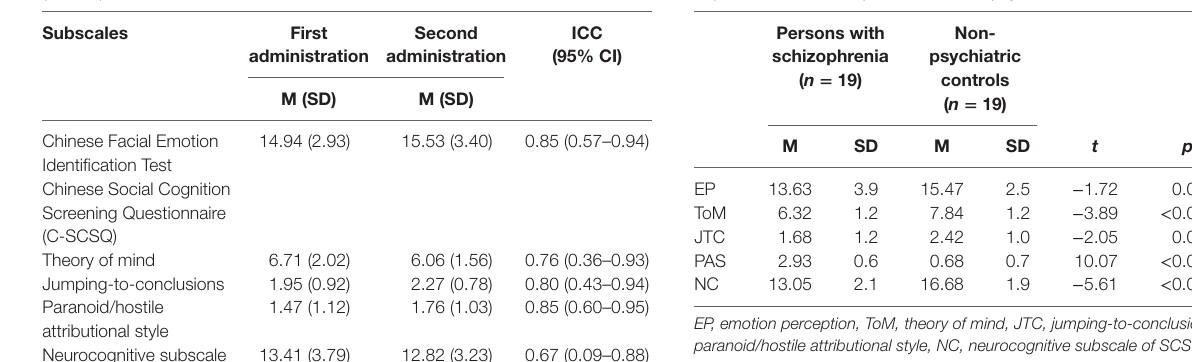
TaBle 4 | Comparison of social cognitive performance between matched pairs of persons with schizophrenia and non-psychiatric controls.